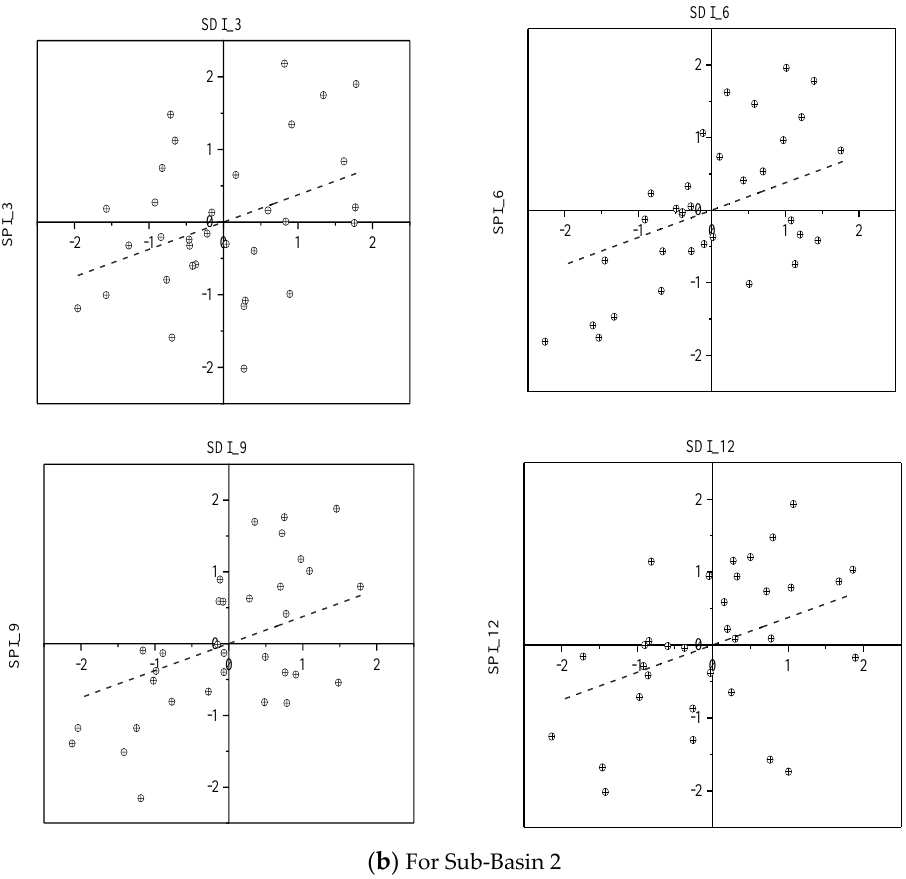
Figure 6. The linear relationship between SDI and SPI at the four selected time scales.